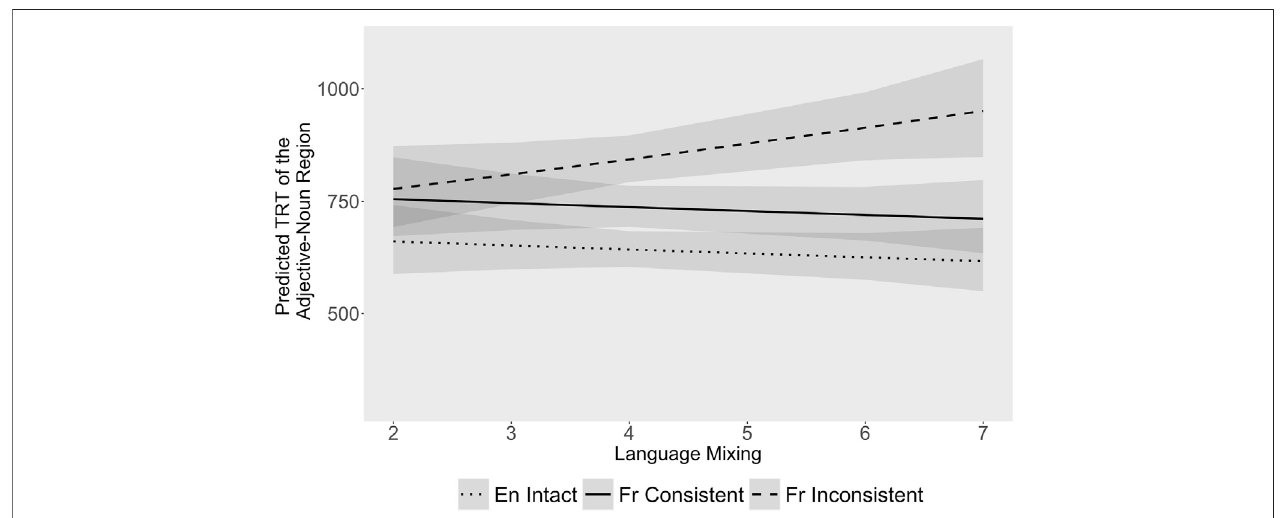
FIGURE 2 | Experiment 1 (French-English bilinguals reading in L2), interaction effect of language mixing (out of 7) on predicted total reading time (in ms) of the adjective-noun region. Shaded area represents plus/minus one standard error of the